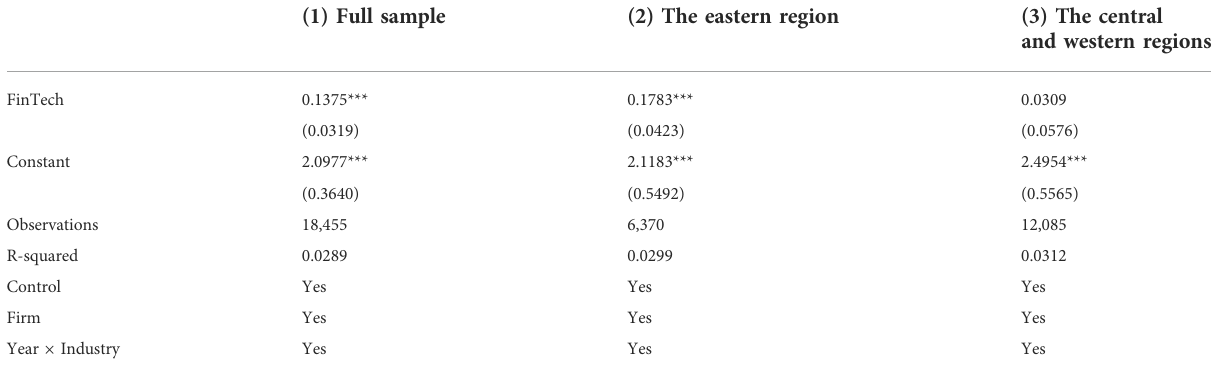
TABLE 10 Further analysis based on the region where the company is located.